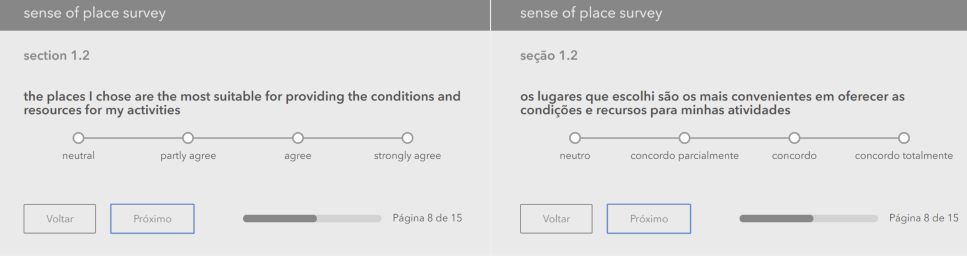
Figure 10: Likert question for place dependence.